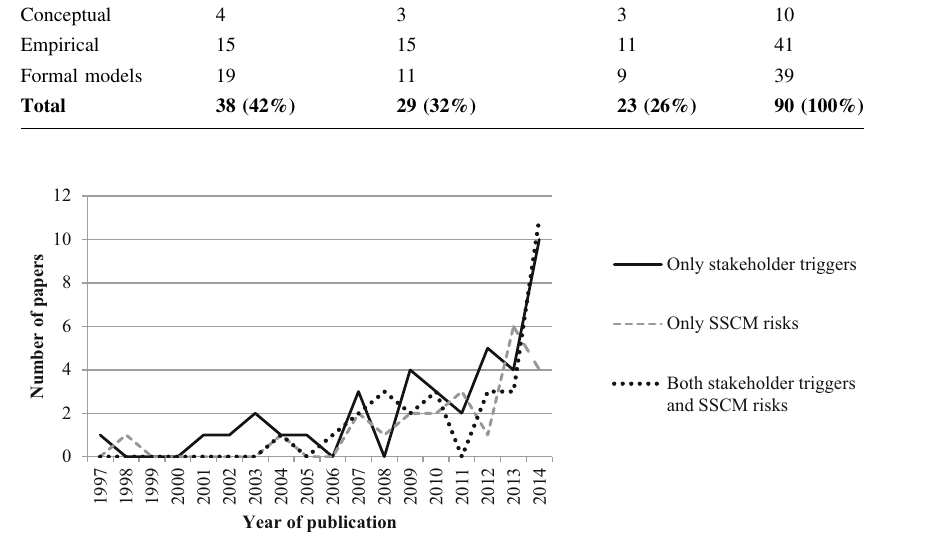
Fig. 4 Distribution of sample papers over publication years focusing on only stakeholder triggers, only SSCM risks, or both